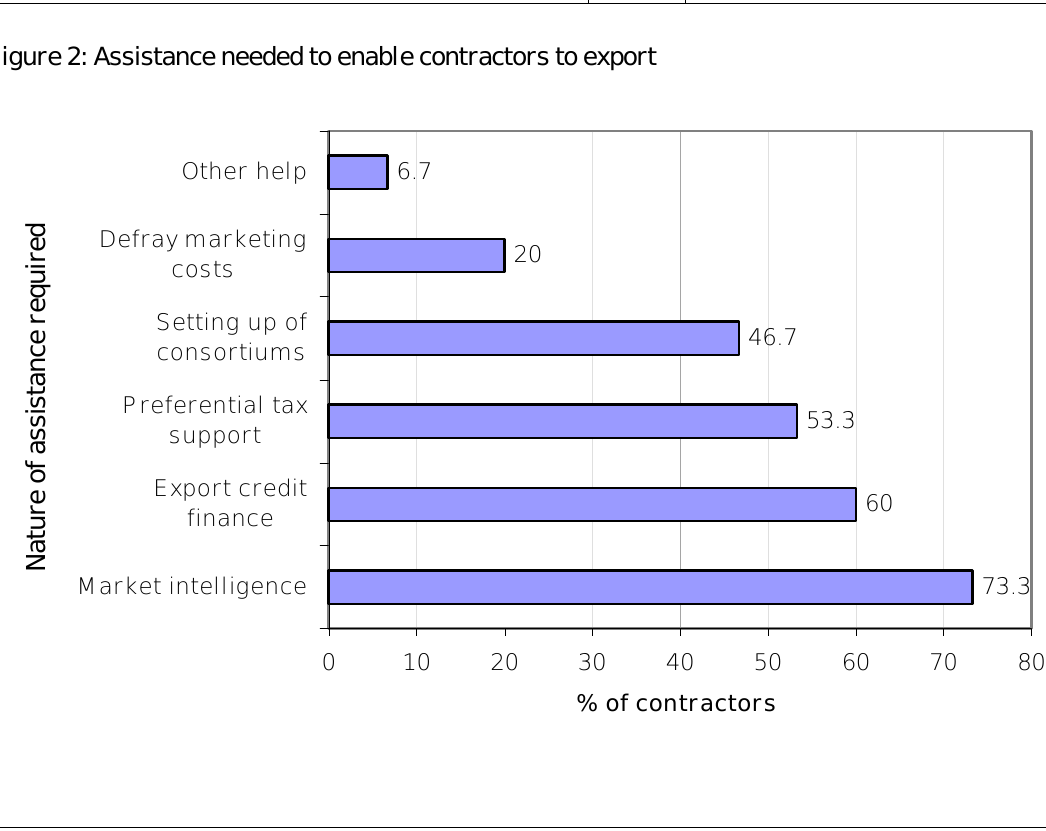
Table 9: Factors that enable contractors winning contracts overseas Important factors enabling contractors winning